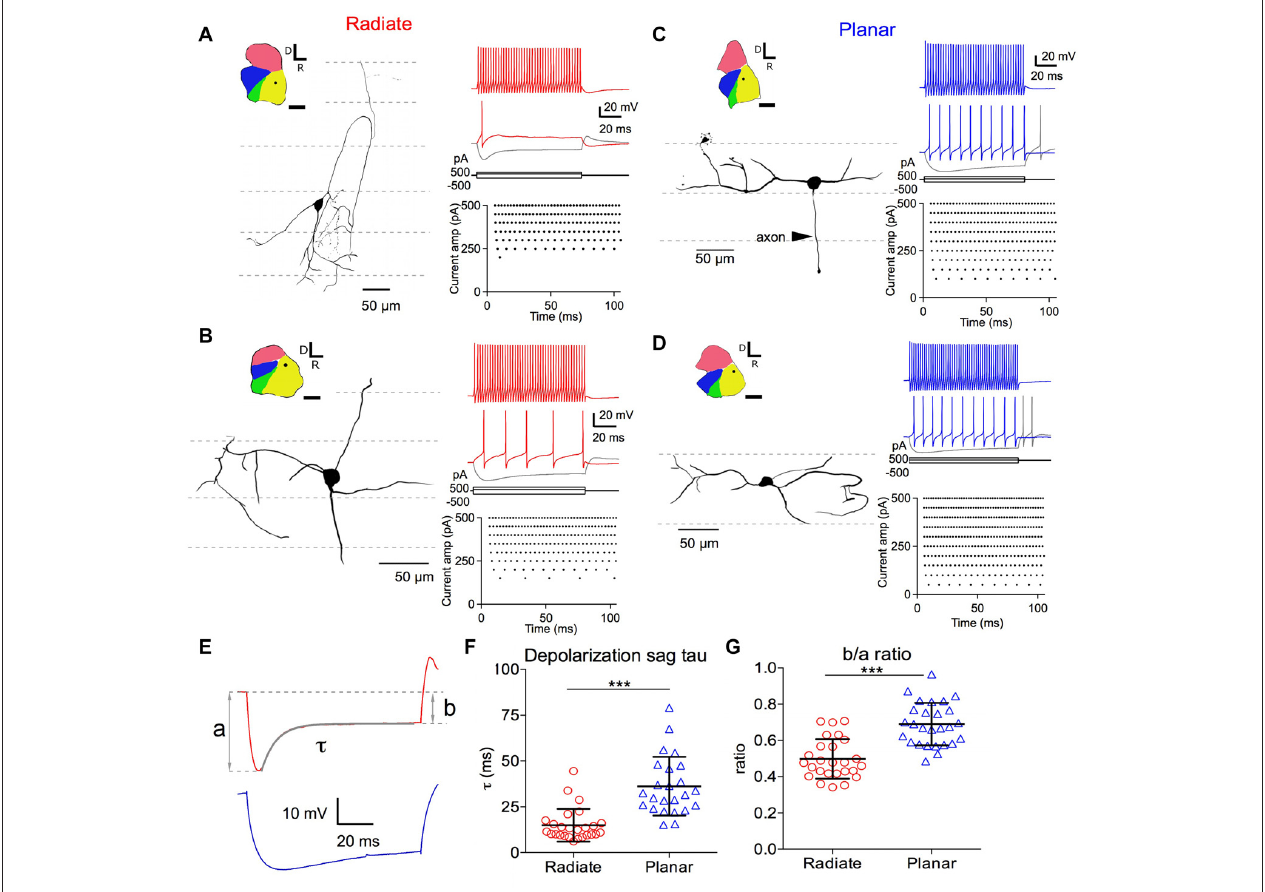
FIGURE 1 | Morphology of radiate and planar neurons and current-evoked responses. Two example radiate neurons (A,B) and two example planar neurons (C,D) are shown. (A) Morphology and current evoked responses of an example radiate cell. Left panel: drawing of the cell morphology (see “Materials and Methods” section). Dashed lines mark the direction of auditory nerve fibers in the anteroventral cochlear nucleus (AVCN), corresponding to the iso-frequency sheets. Inset shows the diagram of the cochlear nucleus slice with the location of the neuron marked as the dot in AVCN. Regions of the cochlear nucleus are color coded to show the auditory nerve root area in green, AVCN in yellow, PVCN in blue, and dorsal cochlear nucleus (DCN) in red. All cochlear nuclei are shown in the same orientation, although recordings were made in slices from both left and right side cochlear nuclei. Calibration bar: 500 µ m. Right top panel: responses to current injections at three levels: +500 pA, 200 pA (threshold current level), and − 500 pA (trace in gray). Right bottom panel: raster plot of spikes evoked at different current injection levels (Current amp). Notice that only a single onset spike was evoked at the threshold current of 200 pA. (B–D) Example neurons with the same layout as in (A) . Notice that radiate neurons have dendrites that extend across the auditory nerve fibers (A,B) , whereas planar neurons have dendrites that run parallel to the auditory nerve fibers (C,D) . Current levels in all neurons included +500 pA (color) and − 500 pA (gray), and a just- suprathreshold depolarizing current (in color; current levels are +150 pA in (B) , +100 pA in (C) , +50 pA in D ). (E) Quantification of the depolarizating sag using responses to 100 ms current injections that hyperpolarized the membrane potential to a peak of − 90 mV. Example traces are from the radiate neuron in (A) (red) and the planar neuron in (C) (blue),